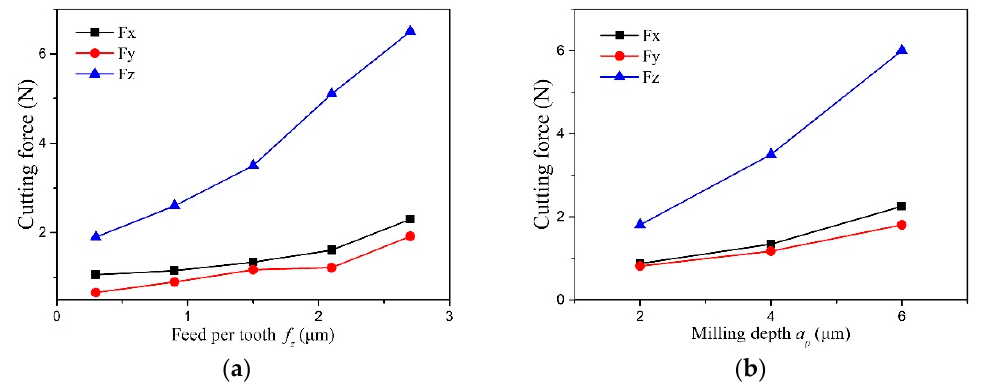
Figure 4. The effect of machining parameters on cutting force. ( a ) Cutting force versus feed rate ( a p = 4 μ m). ( b ) Cutting force versus milling depth ( f z = 1.5 μ m).